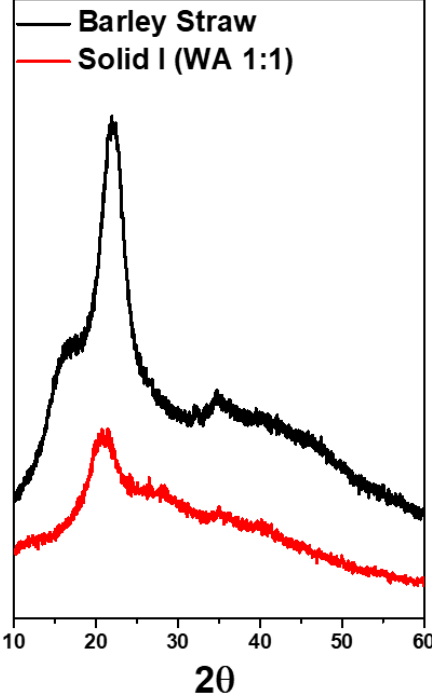
Figure 10. X-ray di ff raction (XRD) spectra of raw barley straw and Solid Figure 10. X-ray diffraction (XRD) spectra of raw barley straw and Solid I.